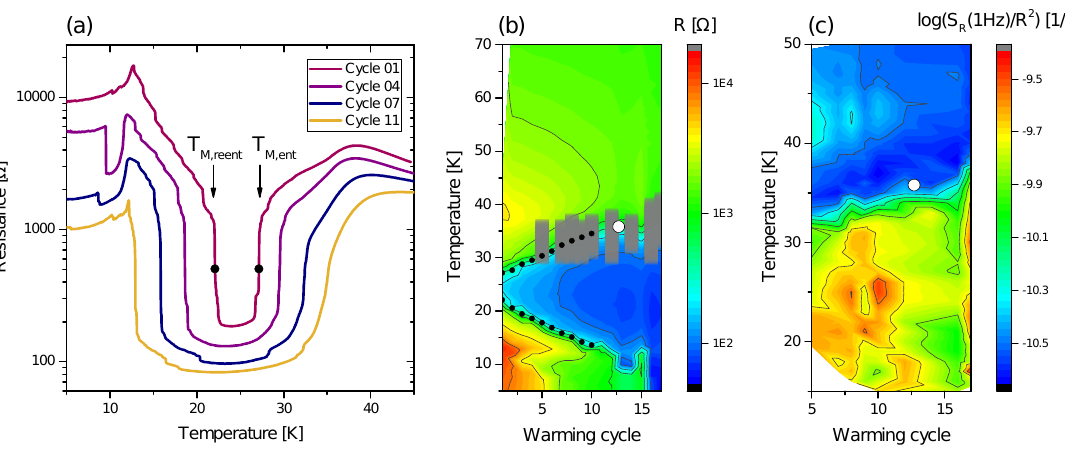
Figure 12. Resistance and noise measurements at the Mott transition in partially-deuterated κ -[(H 8 -ET) 1 x (D 8 -ET) x ] 2 Cu[N(CN) 2 ]Br with x = 0.75. ( a ) resistance measurements of some selected − warming cycles generated by using different thermal relaxation protocols described in the text. The black points mark the temperatures of the entrance and re-entrance half-maximum resistance jump, indicating the crossing of the Mott transition line; ( b ) contour plot of the resistance vs. temperature and warming cycle. The grey area marks the region where the DDH model shows strong deviations; the white circle indicates the critical point; ( c ) contour plot of the normalized resistance noise PSD taken at 1Hz in dependence of temperature and warming cycle (note different